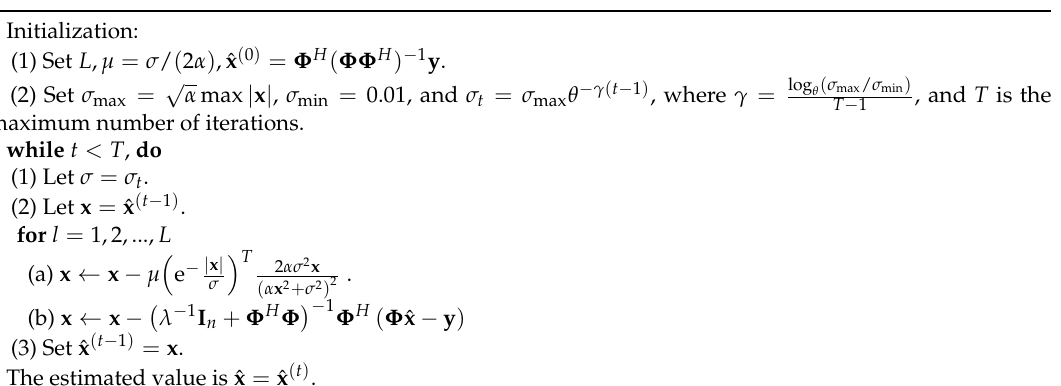
Table 1. Weighted regularized smoothed L 0 -norm minimization (WReSL0) algorithm using the GD